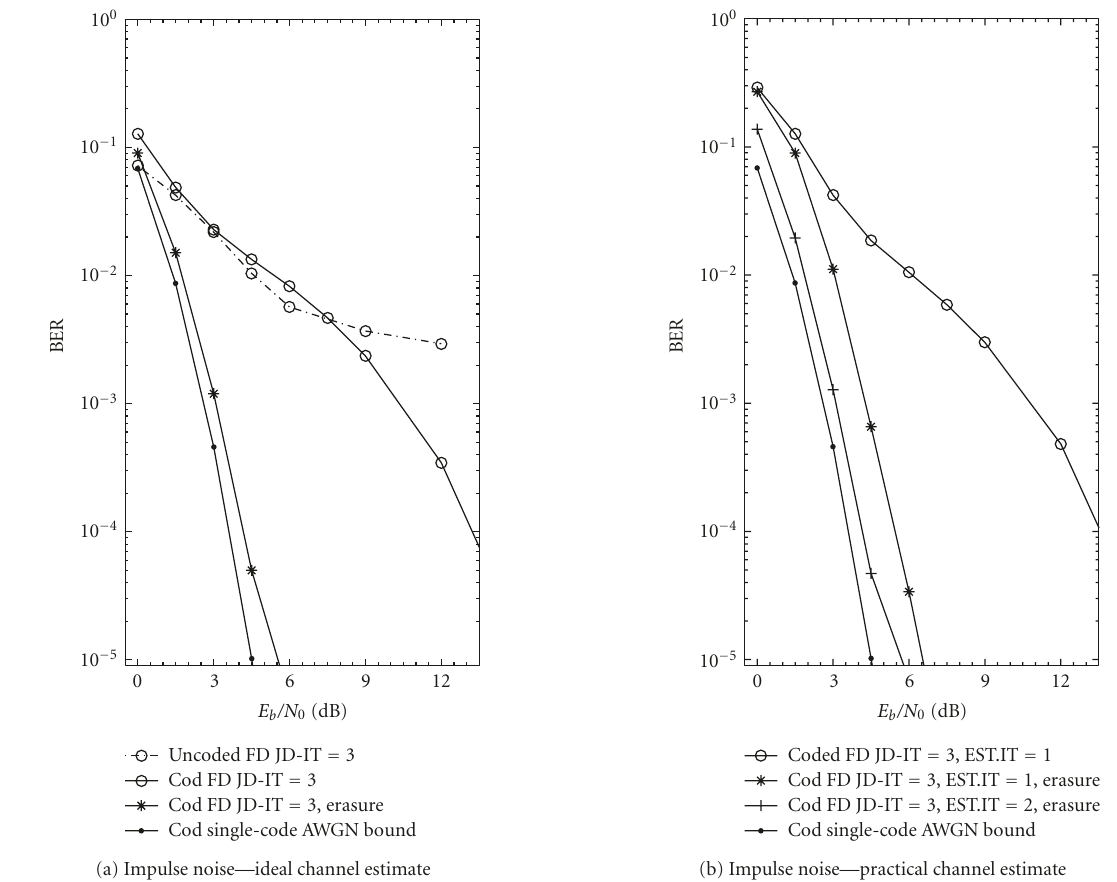
Figure 8: Average BER with one full-rate user and with impulse